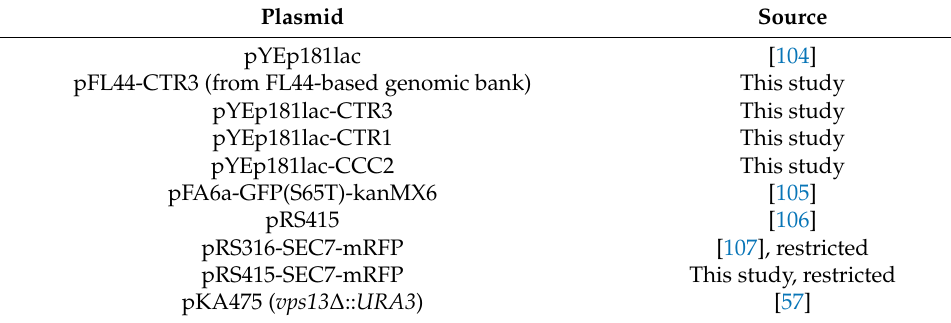
Table 2. Plasmids used in this